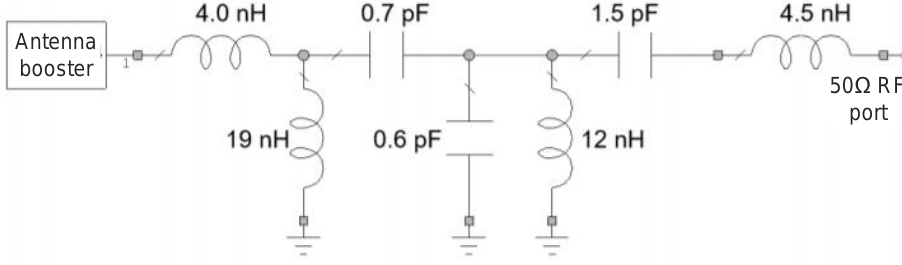
Figure 2. Multiband matching network using SMD inductor and capacitors. The part numbers are: 4.0 nH LQW15AN4N0G80; 19 nH LQW18AN19NG80; 0.7 pF GJM1555C1HR70WB01; 0.6 pF GJM1555C1HR70WB01; 12 nH LQW18AN12NG10; 1.5 pF GJM1555C1H1R5WB01; 4.5 nH LQW15AN4N5G80.